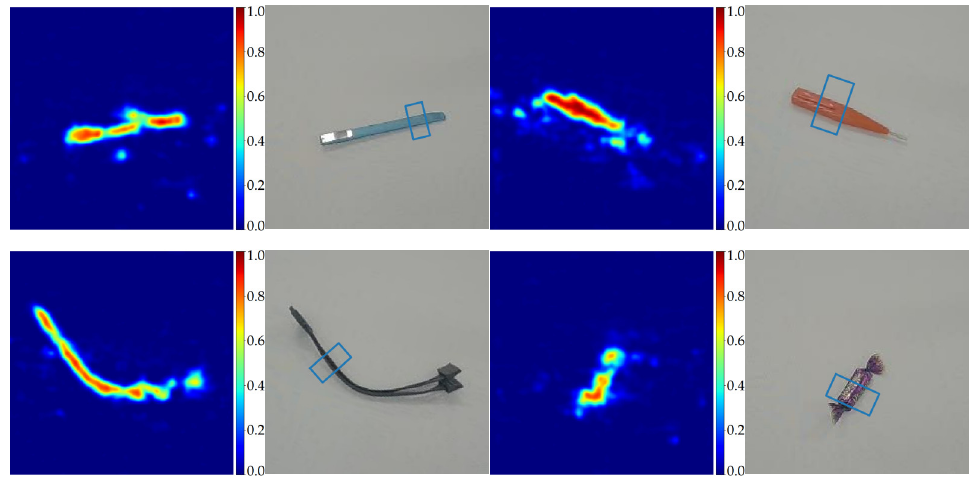
Appendix B: Sample of Unsuccessful Grasps. The first and third columns shows the quality maps for each image. The quality heatmaps characterizes the degree of confidence that each pixel is a valid grasping location. Unsuccessful grasps are marked as blue rectangles in the second and the fourth columns.